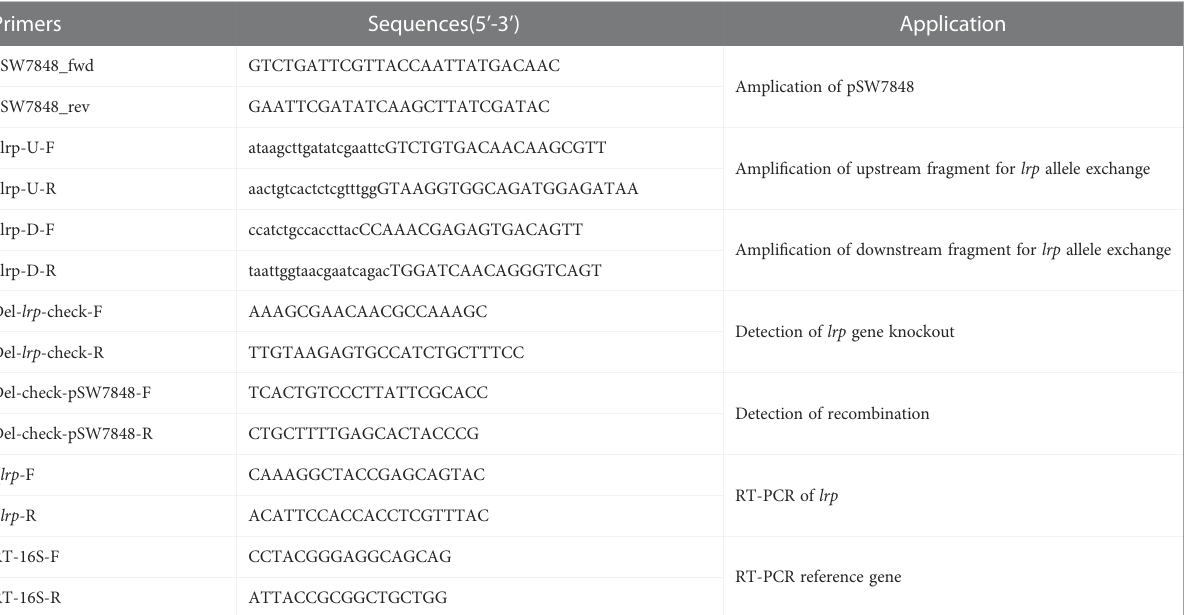
TABLE 2 PCR primers used in this